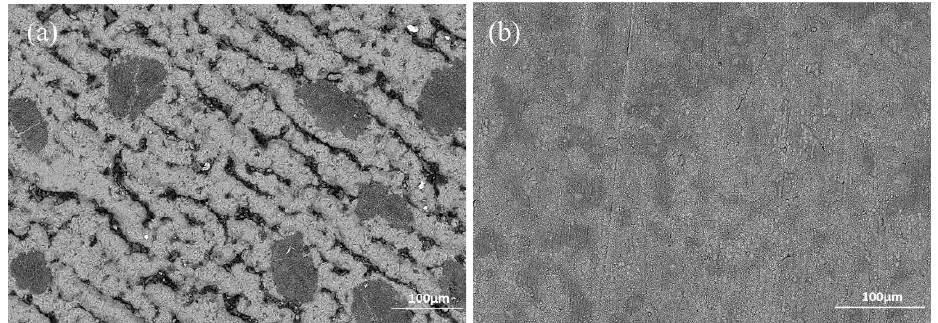
Figure 11. SEM image ( a ) and point quantitative elemental measurements ( b ) for cross-sectioned Ti aluminised at 1000 °C for 10 h.